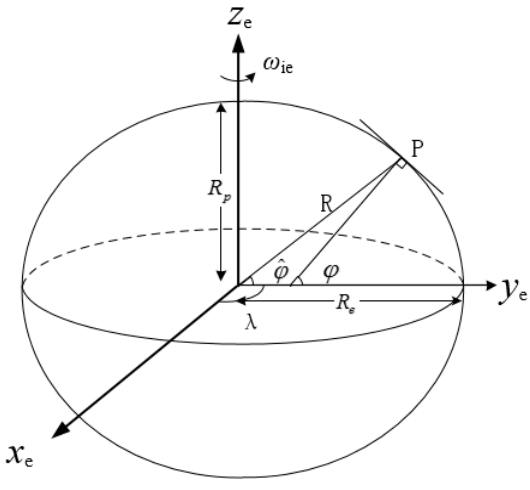
Figure 3. Description of the reference ellipsoid Earth model.